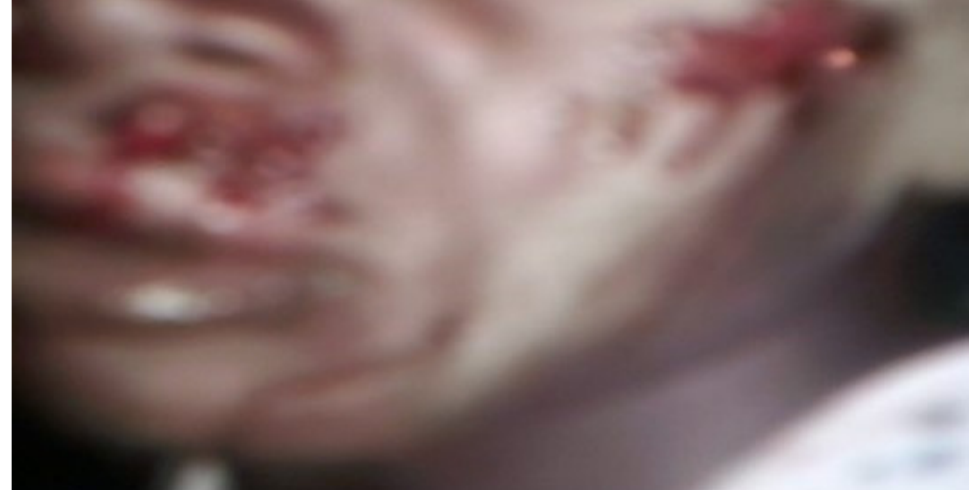
Figure 10. Blood on a participant’s face and shirt after an attack, which made him scared of losing his life.